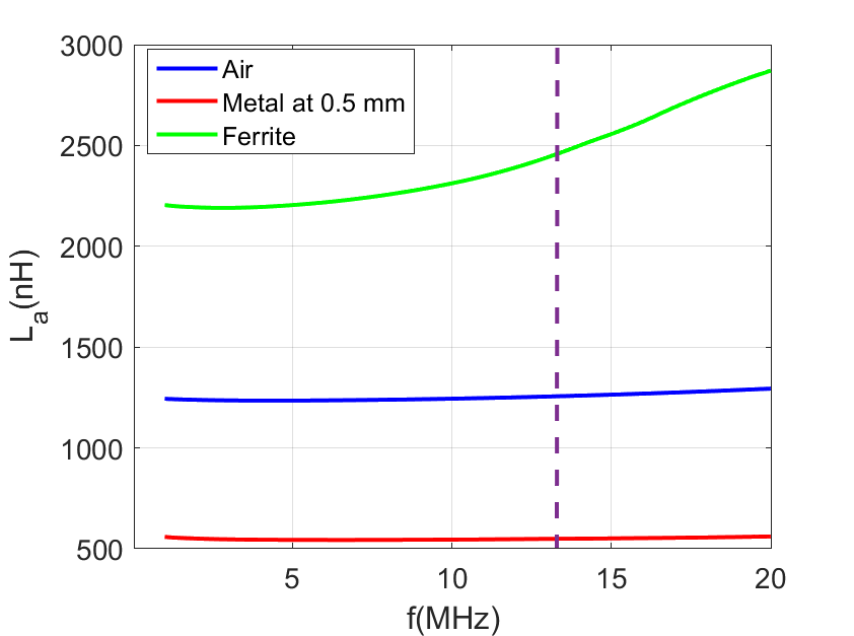
Figure 11. Measurement of the inductance of a loop antenna for different cases: in the air, separated from a metal by 0.5 mm and covered with a ferrite foil on a ground plane.